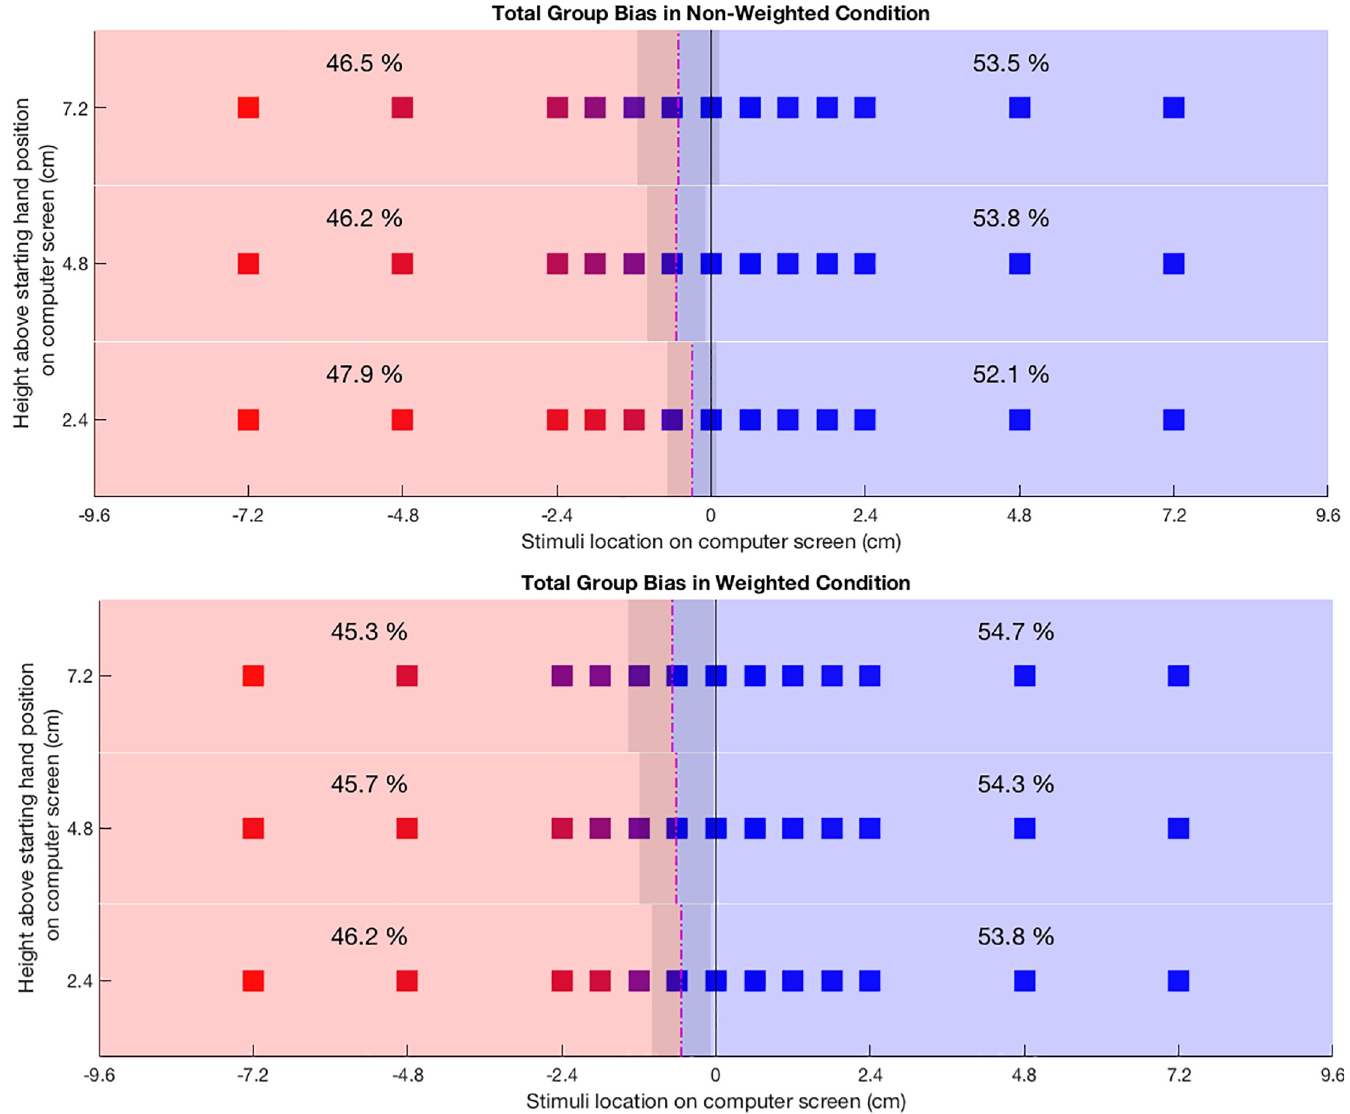
Fig 3. Average reaching frequencies and reaching frequency midline positions. Each cube represents a stimulus location. Group means of hand selection at stimulus positions are color-coded with red squares indicating 100% left hand selection and blue squares indicating 100% right hand selection. Mean percentages of left and right hand use are presented in each hemispace. Dash-dot lines indicate mean reaching frequency midline positions with shaded areas representing their standard deviation. Upper panel: non-weighted conditions; lower panel: condition with weighted left hand glove.